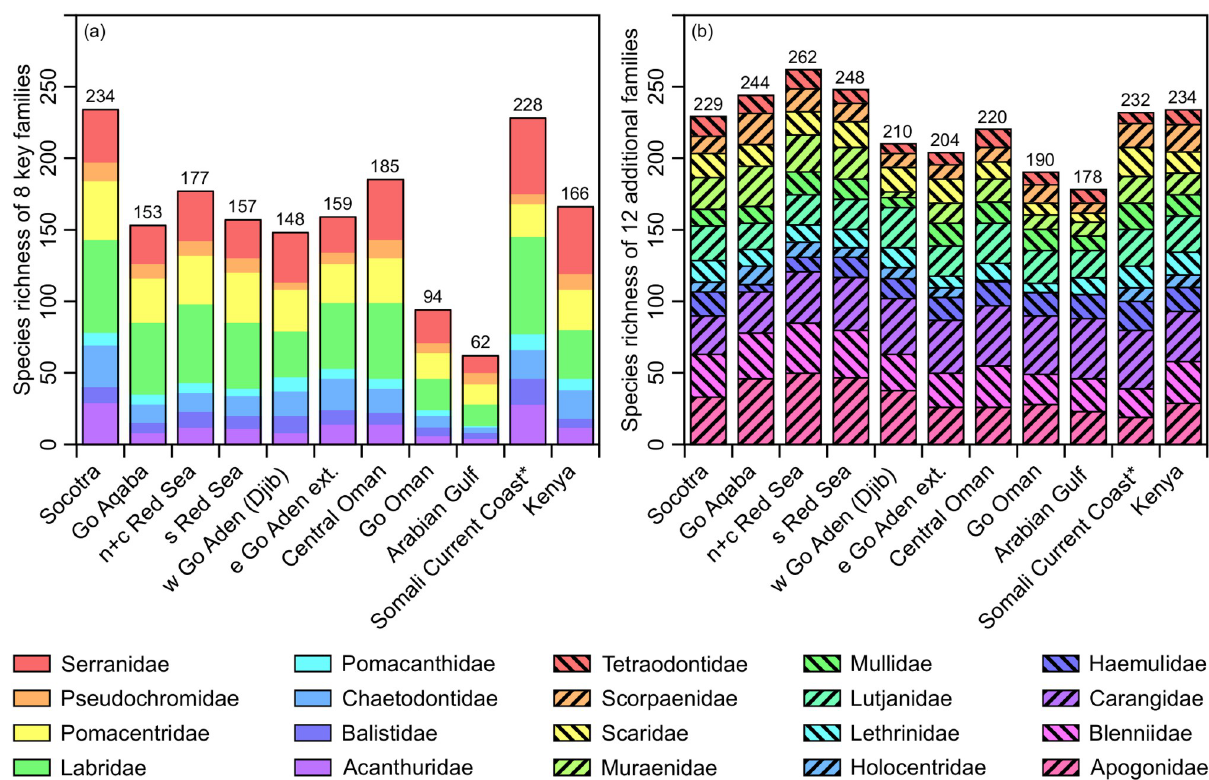
Fig 7. Comparison of species richness in 10 putative Arabian ecoregions (modified from Spalding et al. 2007), and Kenya as external reference ( � surrogate for the eco-regions ’Central Somali Coast’ and northern part of ’Northern Monsoon Coast’ of Spalding et al. 2007), according to (a) 8 key families (modified from Zajonz et al. 2019), and (b) 12 additional core families (this study).